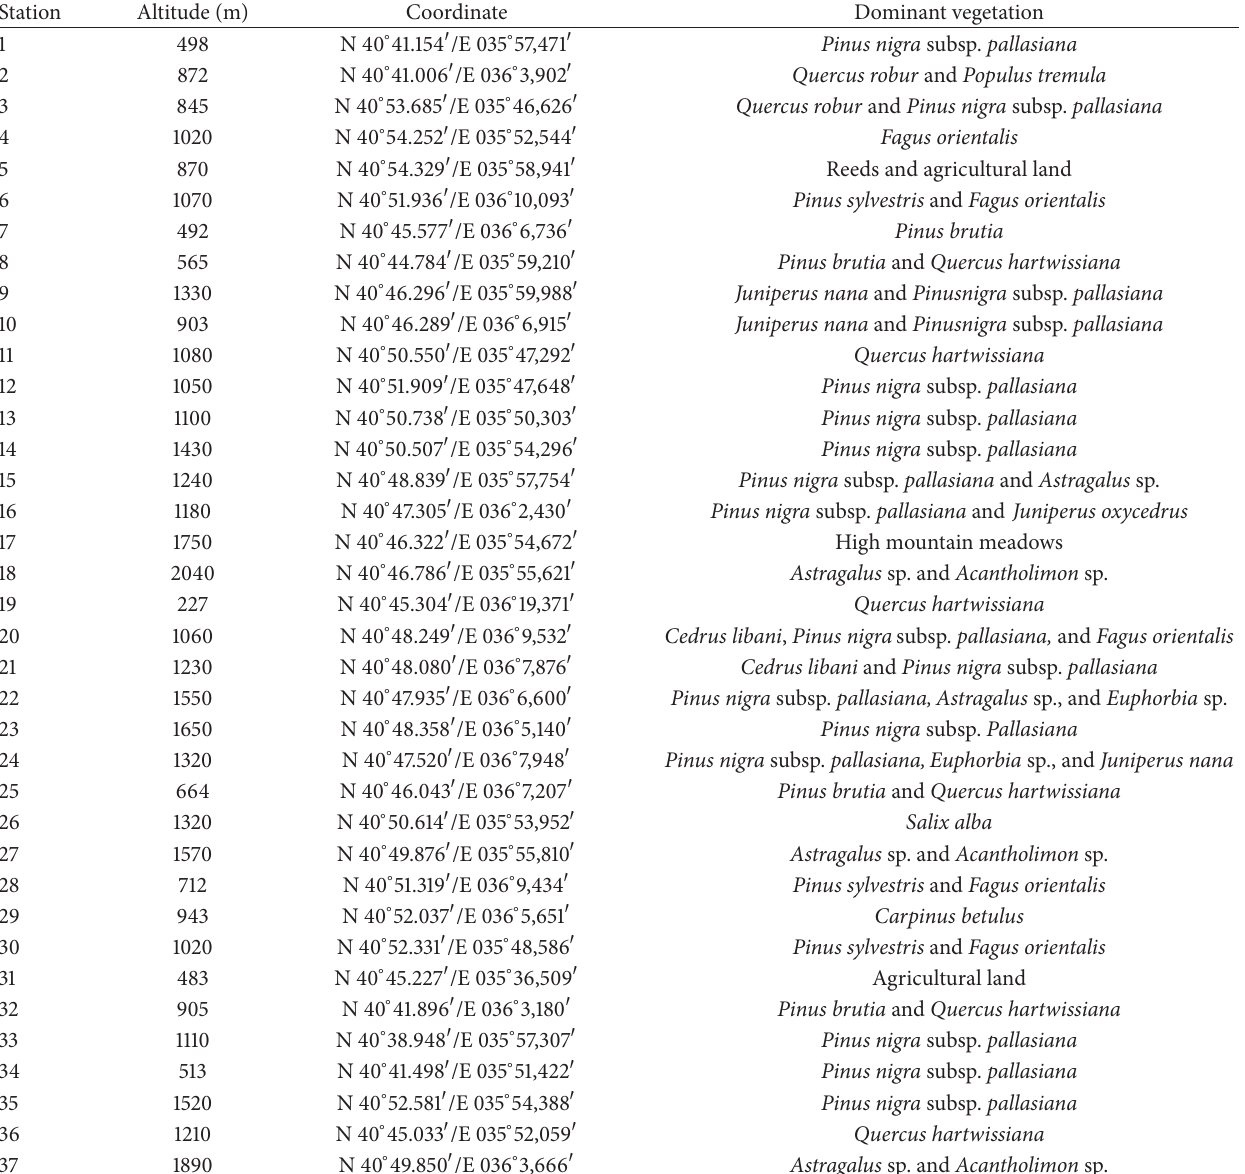
Table 1: Vegetations and coordinate information of